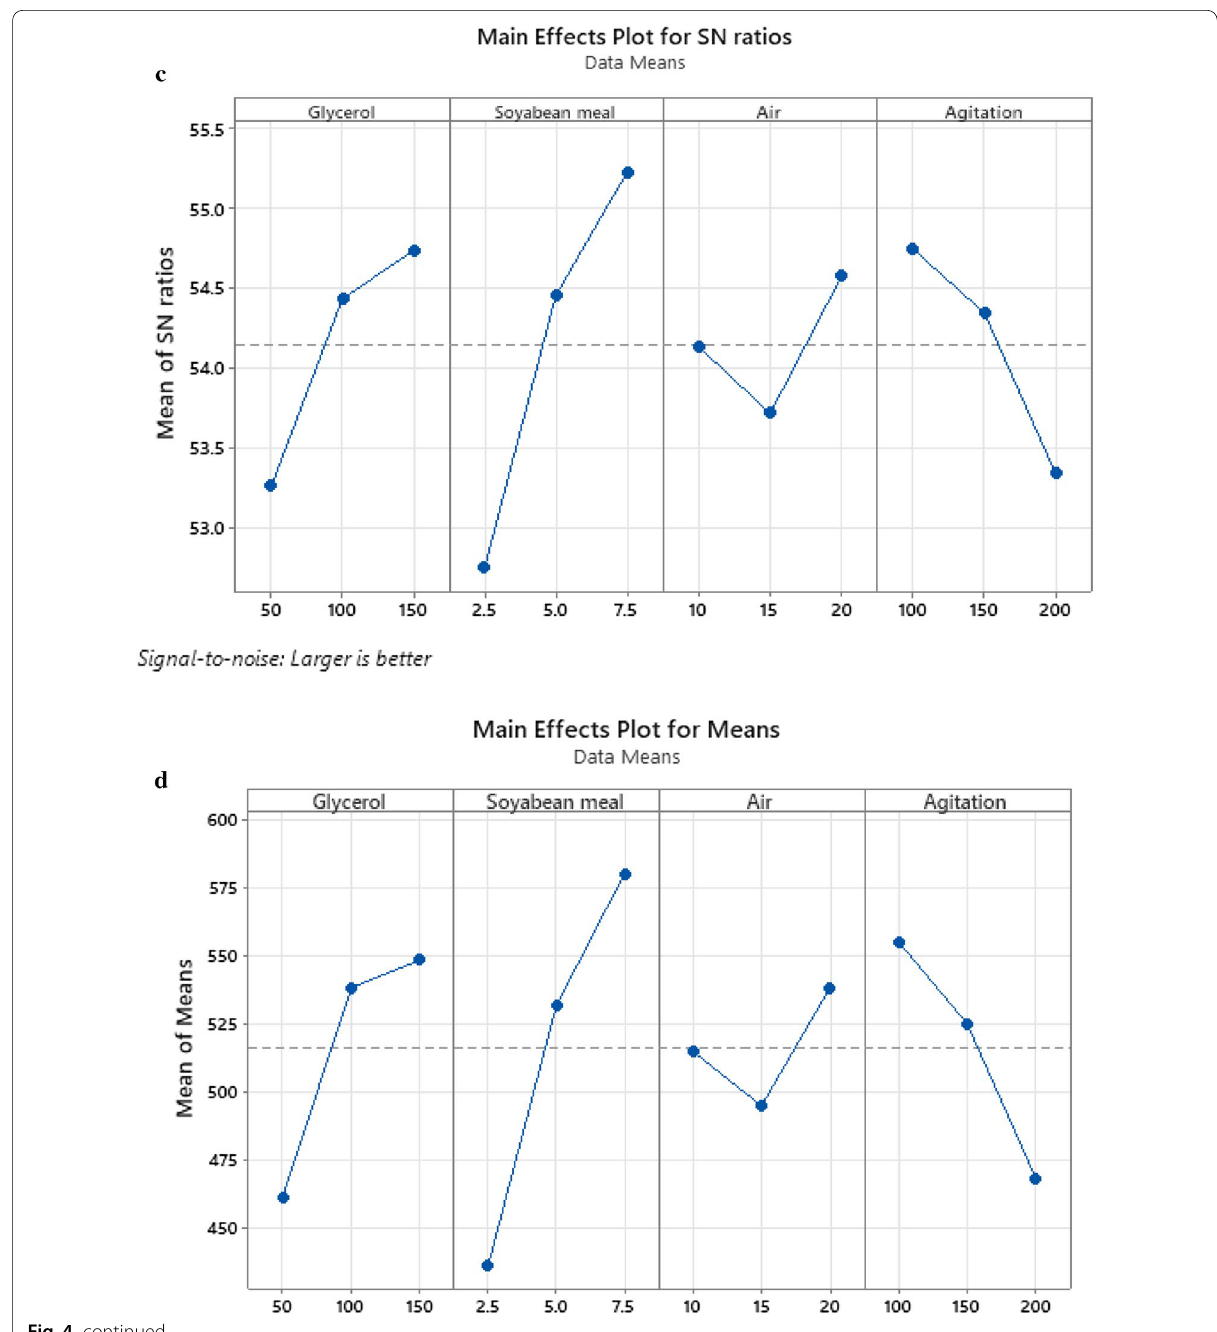
Taguchi orthogonal array design for optimization of biomass and setomimycin production in 30L fermenter Based on the shake flask experiments using OFAT approach, significant factors were identified that had promising impact on fermentation of Streptomyces